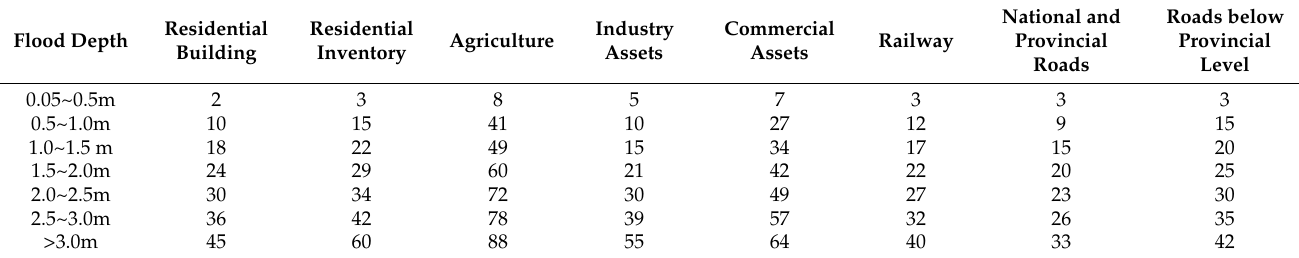
Table 5. Flood depth-loss rate (%).